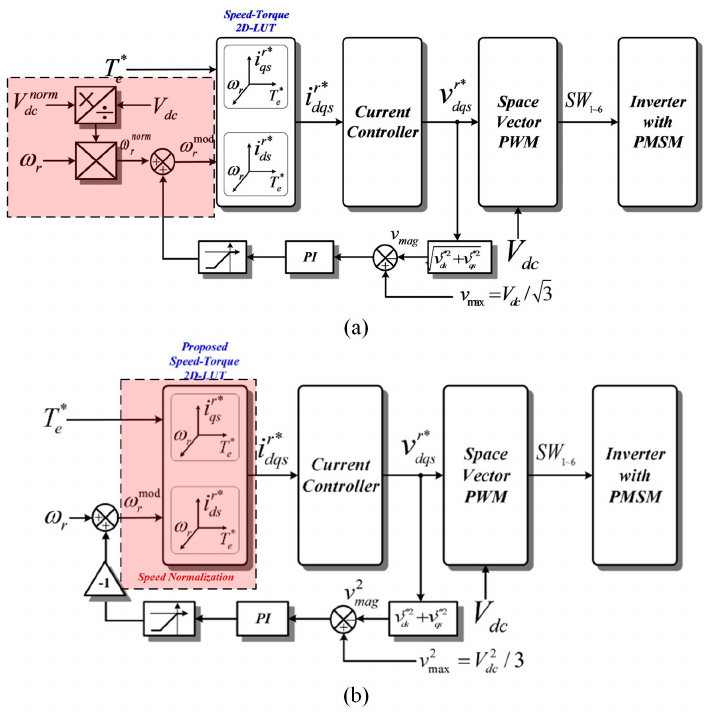
Figure 2. Overall speed-torque 2D-LUT-based PMSM control block diagram: ( a ) conventional [10–13] and ( b ) proposed